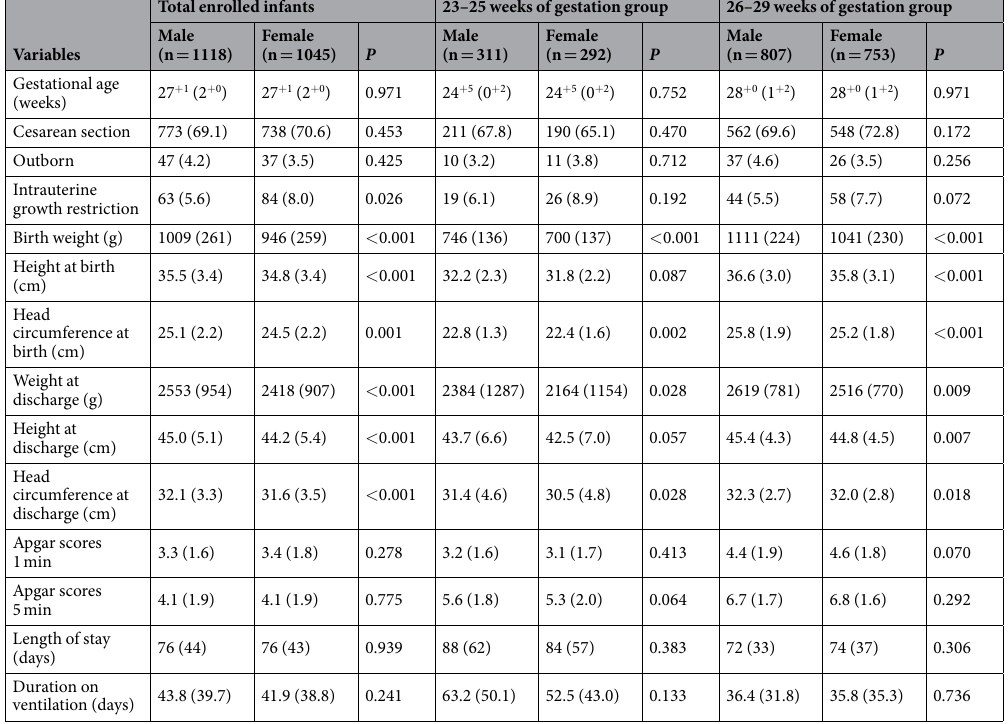
Table 1. Infants’ characteristics and sex difference according to gestational age group. Data are presented as n (%) or mean (SD).